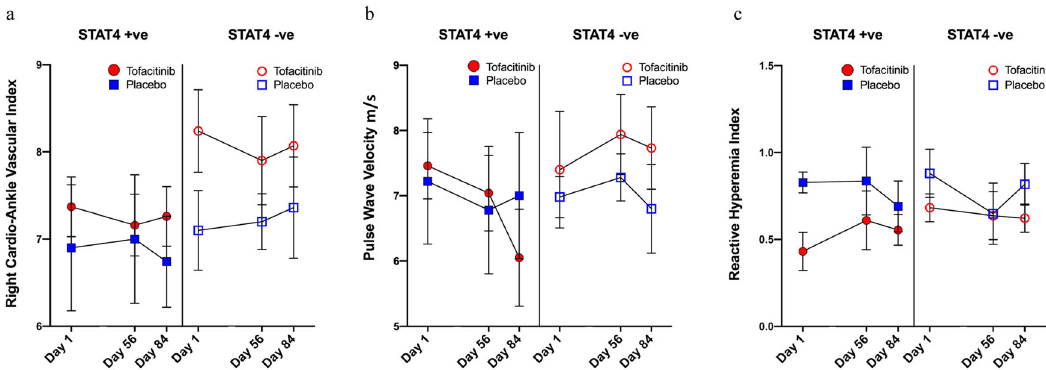
Fig. 4 Tofacitinib improves arterial stiffness and endothelial dysfunction in association with STAT4 risk allele status. a Right cardioankle vascular index (CAVI): Results represent changes in CAVI in subjects on tofacitinib vs placebo in STAT4 risk allele-positive and -negative subjects during the trial. b Pulse wave velocity (PWV): Results represent changes in PWV in subjects on tofacitinib vs placebo in STAT4 risk allele-positive and -negative subjects during